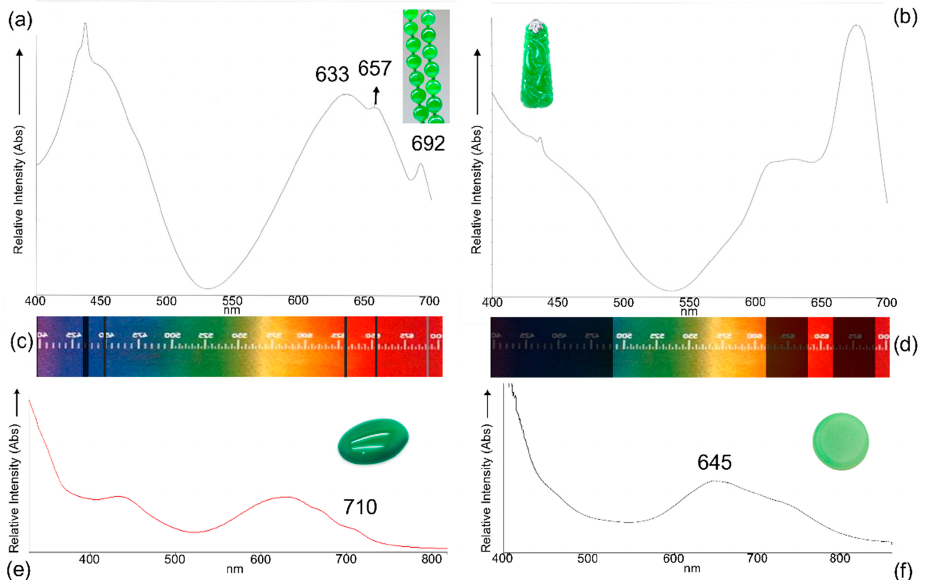
Figure 10. ( a , b , e , f ) UV-Vis/NIR and ( c , d ) gemological handheld spectroscope spectra of Green Stones. Spectra acquired by UV-Vis/NIR spectrophotometer Lambda 950, PerkinElmer, equipped with integration sphere, Spectrum Software. The two “handheld” spectra ( c , d ) have been reported flipped to highlight the similarities in the band absorption in correspondence to the top spectra. In particular, ( a ) Natural Imperial Green Jadeite-Jade A, the sharp absorption at about 633, 657, and 692 nm, correlated with Cr 3+ , should be noted; ( b ) Treated Jadeite-Jade B + C, note the broadening of the bands corresponding to orange and red visible ranges (photos and spectra: M. Musa, gemological handheld spectroscope images: L. Greggio, GECI.); ( e ) Dyed Green chalcedony (Jade imitation), it is interesting to observe the absorptions in the same areas of the natural Cr 3+ but showing characteristic broader bands, especially about 710 nm. These impregnations and modern dyeing treatments are performed using chromium-rich pigments; ( f ) Natural chrysoprase color is due to nickel-associated minerals, as shown by the characteristic UV-Vis/NIR spectrum, with the absorption centered at about 645 nm. (Data and photos: M. Musa, GIG) .